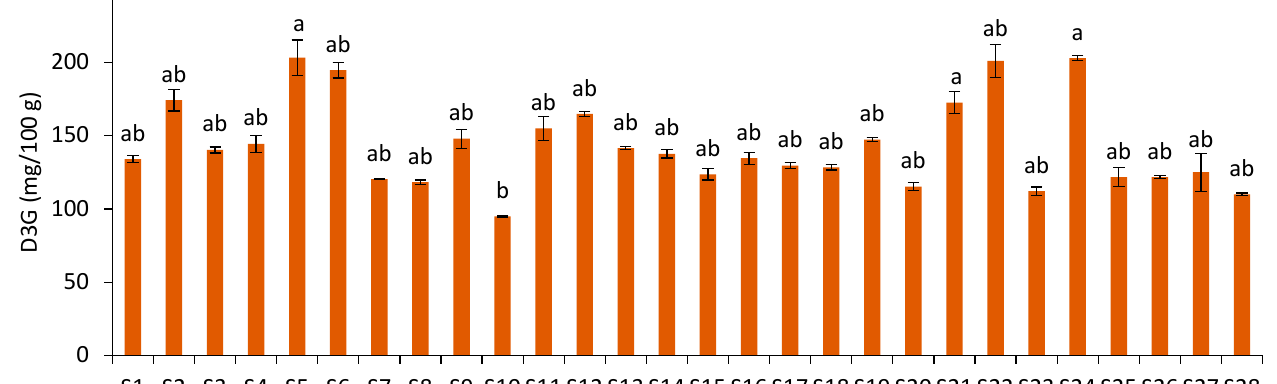
Figure 4. Delphinidin-3- O -glucoside content of JPF samples. Different letters in different samples correspond to significantly different values ( p < 0.05).